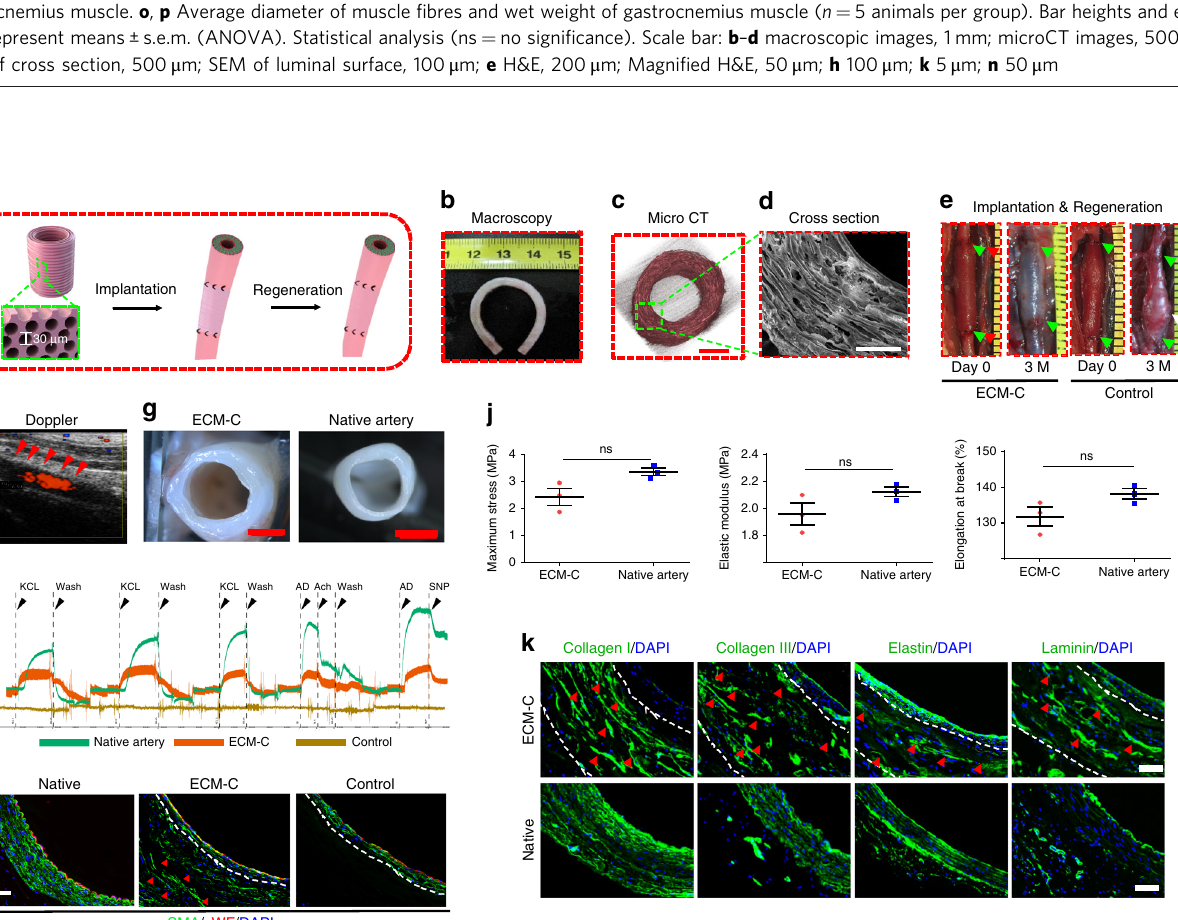
Fig. 7 Characterisation and utility of tubular scaffolds with circumferentially aligned microchannels in vascular regeneration at 3 months. a Schematic illustration of implantation of the tubular vascular ECM-C scaffolds for artery regeneration of the rat abdominal artery defects. b No kinking formed when the tubular ECM-C scaffolds were folded at 180°. c , d Micro CT and SEM images showing the macroscopic and microscopic appearance of tubular ECM-C scaffolds with circumferentially aligned microchannels observed from the cross section. e The ECM-C vascular scaffolds can withstand the blood pressure after implantation and maintains for 3 months, and remodel into neo-artery, integrating with the host artery. The control scaffolds formed aneurysm at 3 months. The green arrowheads represent the suture line of the anastomosis. The white arrowheads represent the aneurysm formation site. f The patency was evaluated by Laser Doppler ultrasound imaging. The red arrowheads indicate the position of ECM-C guided neoartery. g The cross-sectional morphology of ECM-C guided neoartery was close to native artery under the stereomicroscope. h Examination of the physiological functions of neo-artery revealed obvious sensitivity to vasodilators and vasoconstrictors, which is similar to native artery. The functional signals of control scaffolds were undetectable ( n = 3 animals per group). i Immuno fl uorescence double staining showed the distribution of endothelial cells (vWF, red) and vascular smooth muscle cells ( α -SMA, green) in native artery, ECM-C guided neo-artery and control scaffolds. White dashed lines indicate the border of the scaffolds. Red arrowheads indicated the regenerated VSMC along the microchannels. j Comparison of the mechanical properties of neo-artery and native artery including maximum stress, elastic modulus, and elongation at break (from left to right) ( n = 3 animals per group). k Immuno fl uorescence staining showing the distribution of collagen I and III, elastin and laminin in ECM-C guided neoartery and native artery. White dashed lines indicate the border of the ECM-C scaffolds. Red arrowheads represent the deposited ECM components within the microchannels. Bar heights and error bars represent means ± s.e.m. ( t -test). Statistical analysis (ns = no signi fi cance). Scale bar: c , 500 μ m; d , 200 μ m; g , 1 mm; i , k , 50 μ